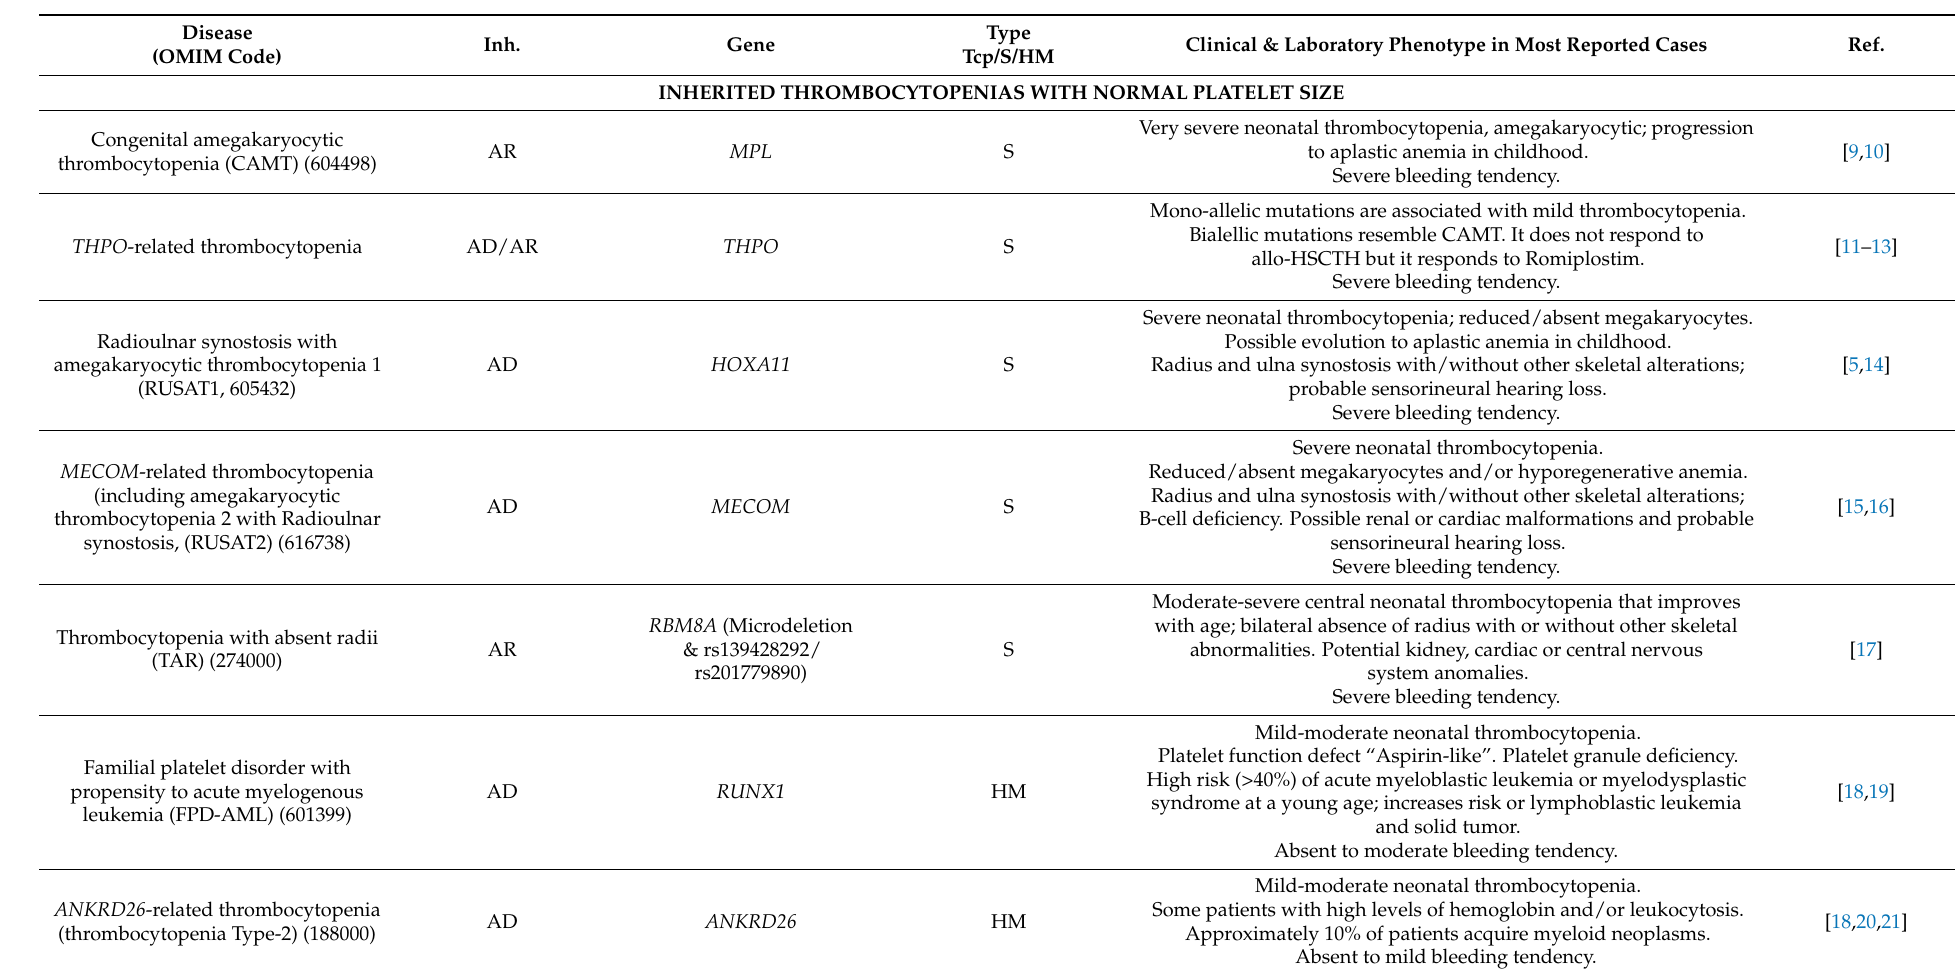
Table 1. General features of inherited